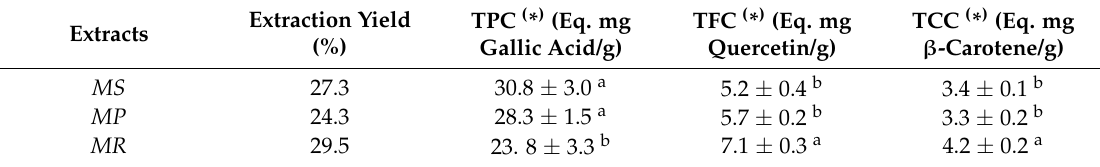
( * ) Data from three independent experiments; all contents are expressed versus dry plant material. Values in the same column sharing different letters are significantly different ( p < 0.05). Mentha spicata L. (MS), Mentha pulegium L. (MP) and Mentha rotundifolia (L.) Huds (MR). Eq: